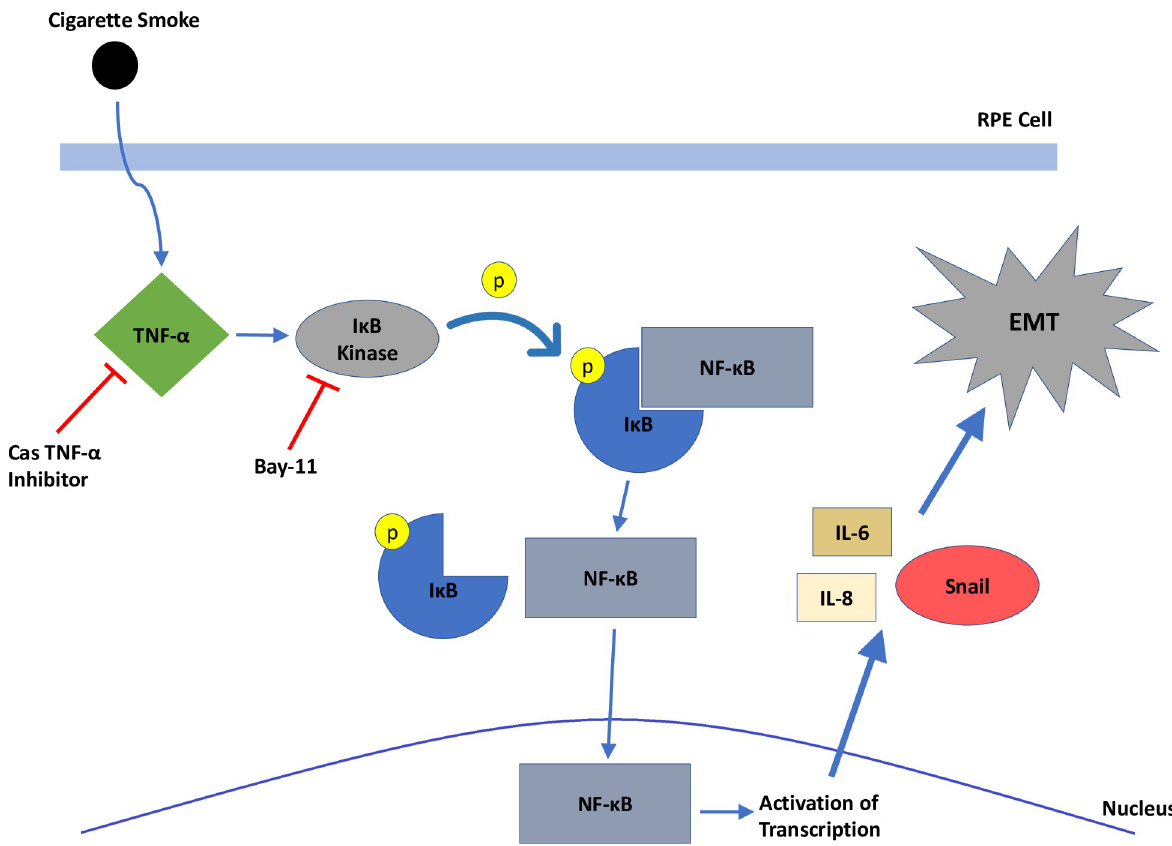
Fig 6. A model of cigarette smoke mechanism of action on RPE cells. Cigarette smoke stimulates production of TNF- α intracellularly, which activates I κ B kinase, phosphorylating I κ B. This results in dissociation of I κ B from NF- κ B, which enters the nucleus to activate transcription of Snail, IL-6, and IL-8. Snail triggers downstream factors involved in epithelial-mesenchymal